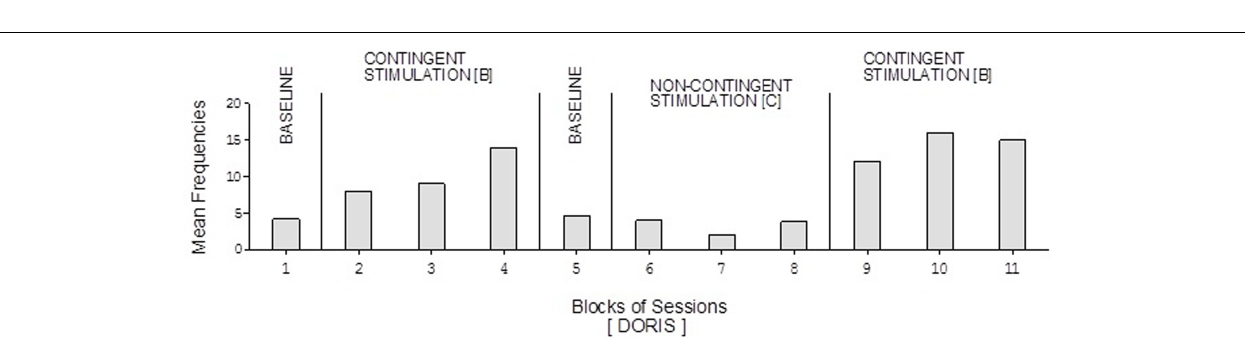
FIGURE 1 | Carol’s data during the different phases of the learning test. The bars represent mean frequencies of responses per session over blocks of sessions.The blocks include six and eight sessions during the baseline phases, 15 sessions during the first B phase, and 10 sessions during the C phase and the second B phase.